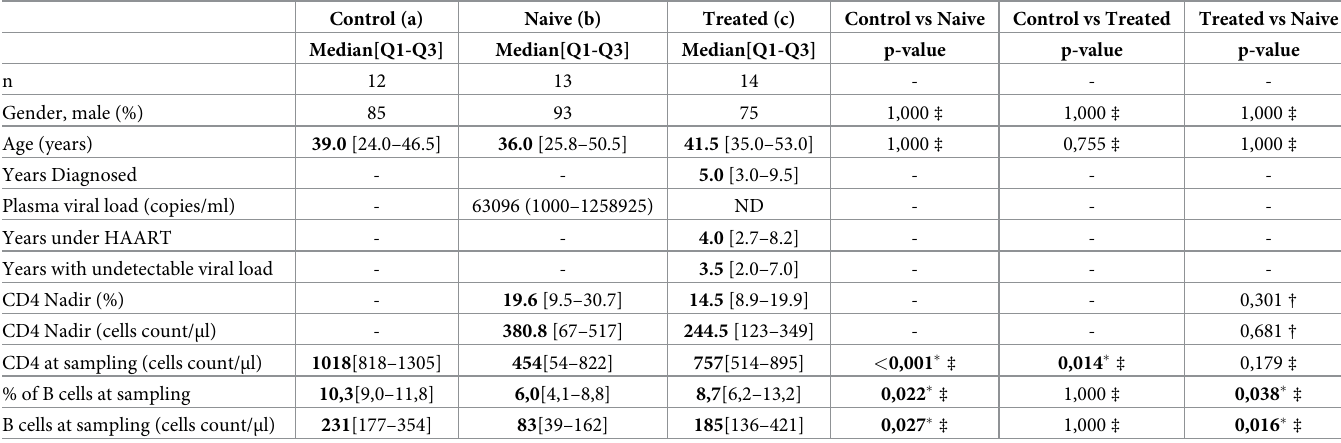
Table 1. Characteristics of HIV + -infected and healthy individuals enrolled for the